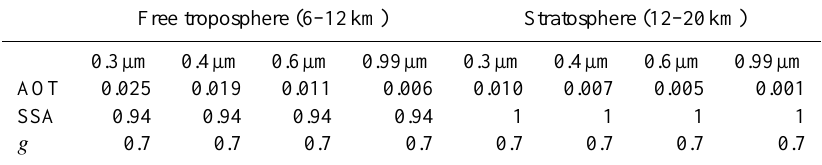
Table 2. Climatology of aerosol optical properties for the free troposphere and the stratosphere issued from Hess et al.